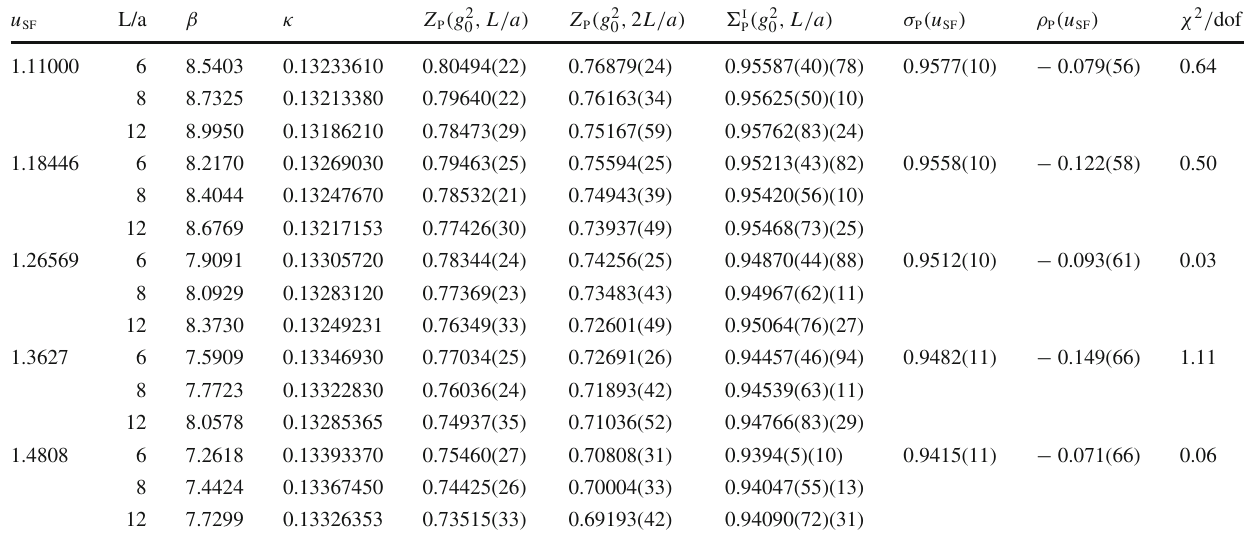
Table 6 Results for Z columnsquotethevalueof